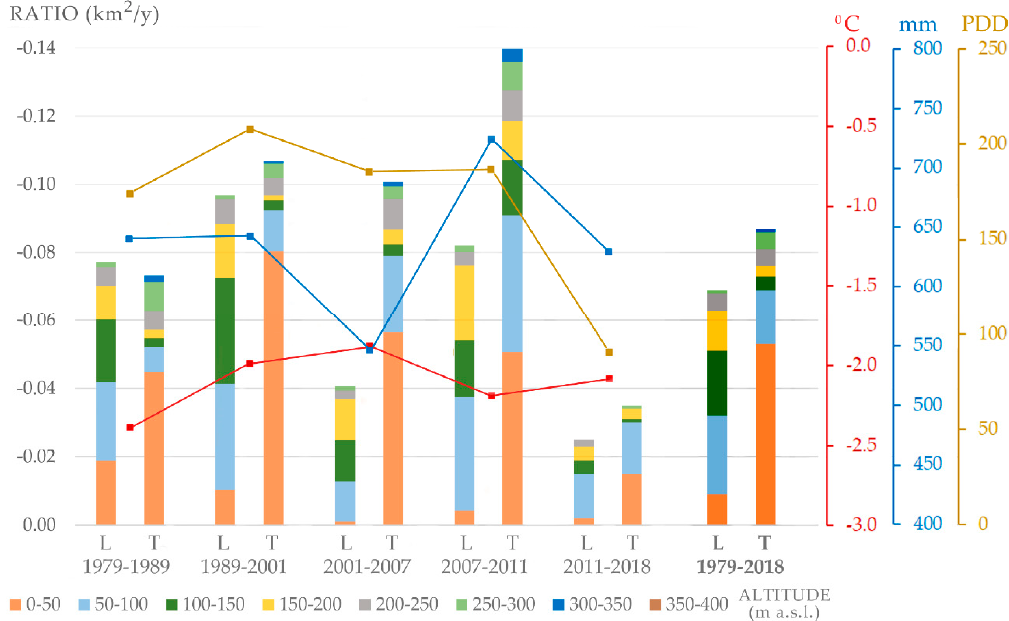
Figure 6. The cumulative chart of the glaciers’ retreat ratio for chosen intervals of altitude and analysed periods (L: land-terminating glaciers; T: tidewater glaciers) based on Table A1 (see Appendix A). The changes of average air temperature, precipitation, and PPD sums in the analysed periods were imposed (based on data presented on the Figure 2).